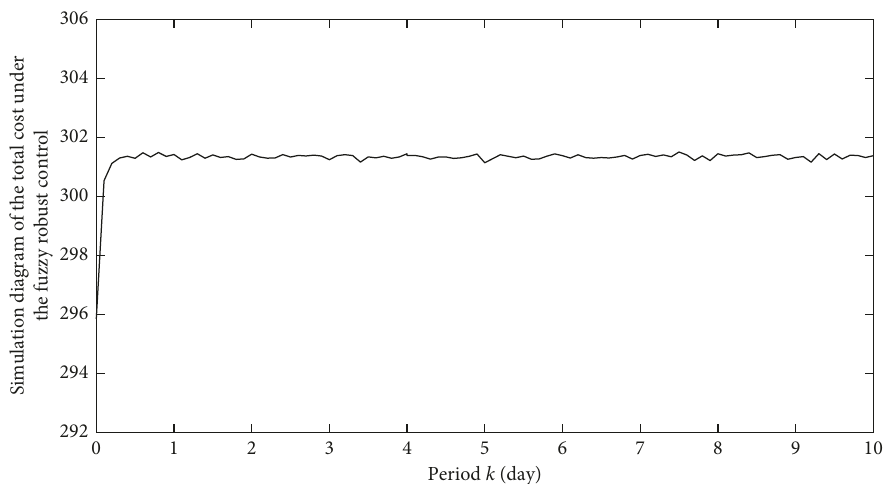
Figure 8: Simulation diagram of the total cost under FRC (unit: × 10 5